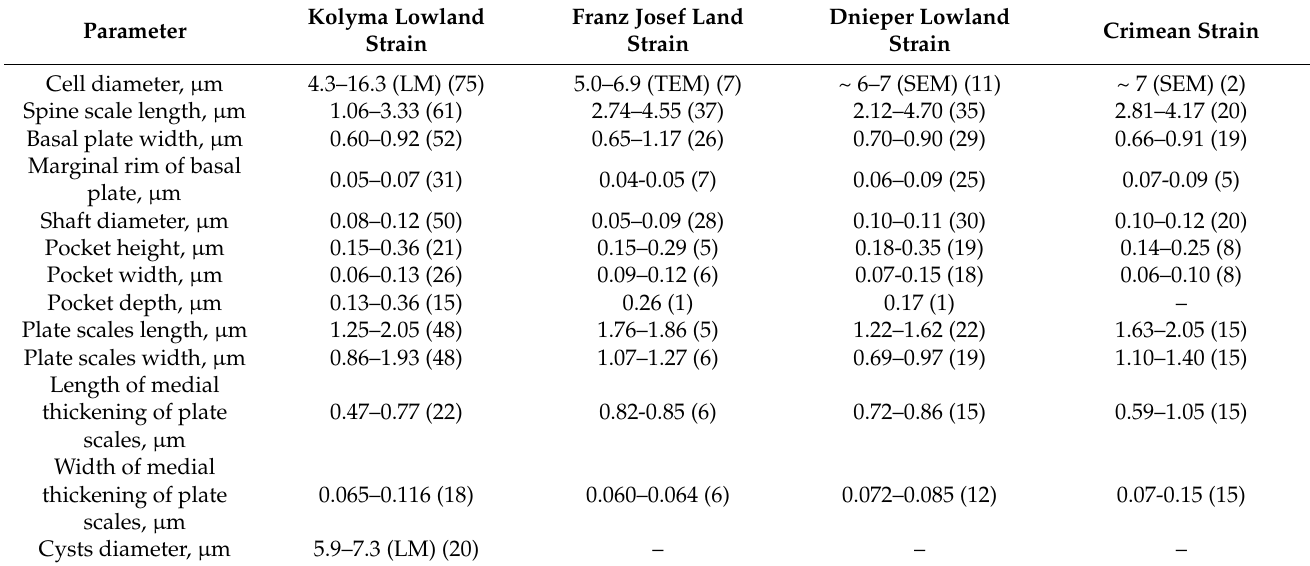
Table 2. Morphological comparison of the skeletal elements of Triangulopteris lacunata gen. et sp. nov. from geographically distant biotopes.